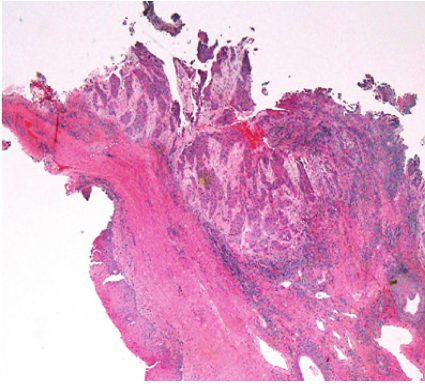
Figure 4: Low power view showing tumor on mucosal surface, in- vading in